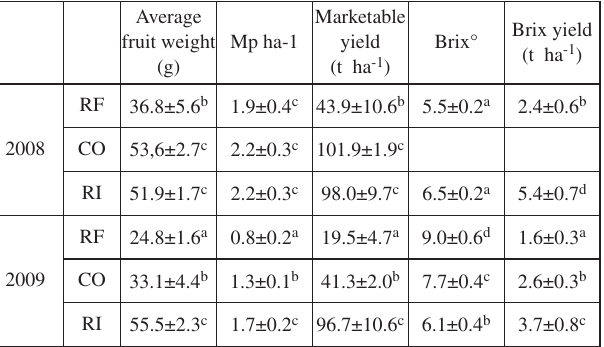
Rainfed (RF) cut off (CO) regularly irrigated (RI). For each column bearing different superscript letter indicate significant differences according to Tukey’s test. Values mean ±